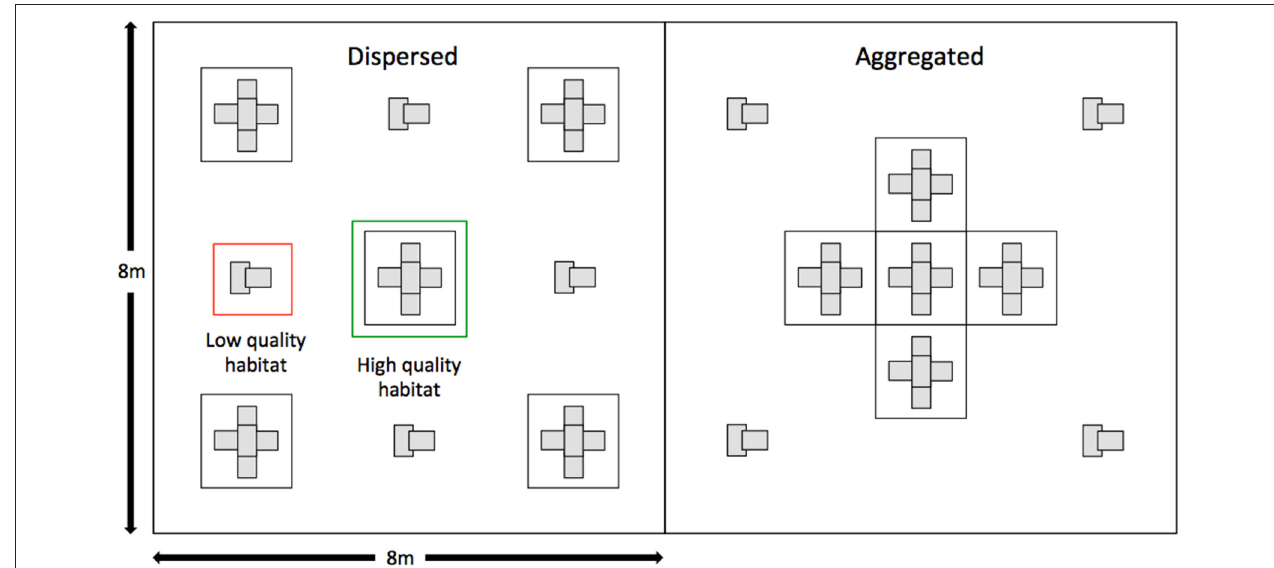
FIGURE 1 | Diagrammatic representation of the two treatments used in the experiment. On the left is the dispersed habitat treatment and on the right is the aggregated treatment. Areas representing high quality and low quality habitat indicated.